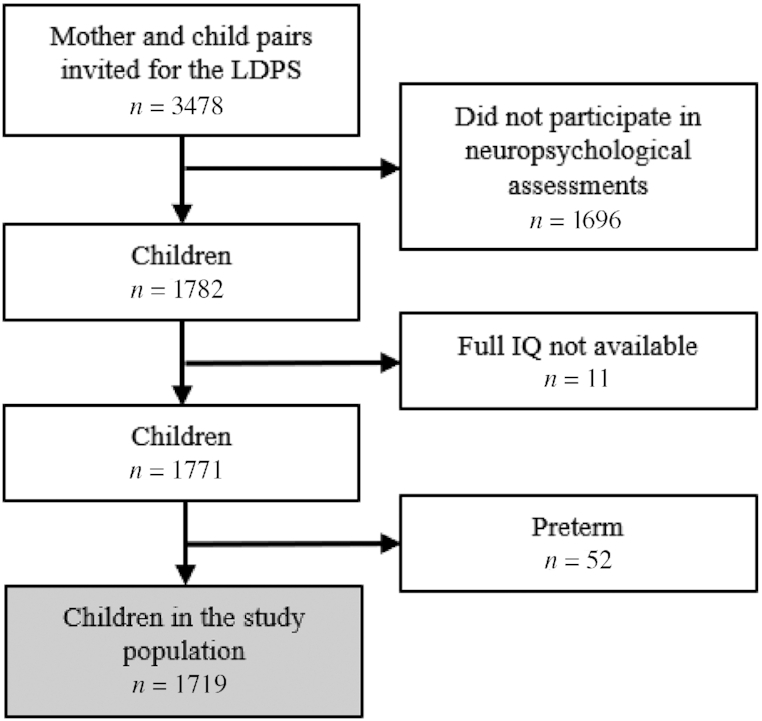
Flowchart of the study population. LDPS, Lifestyle During Pregnancy Study; IQ, intelligence quotient.